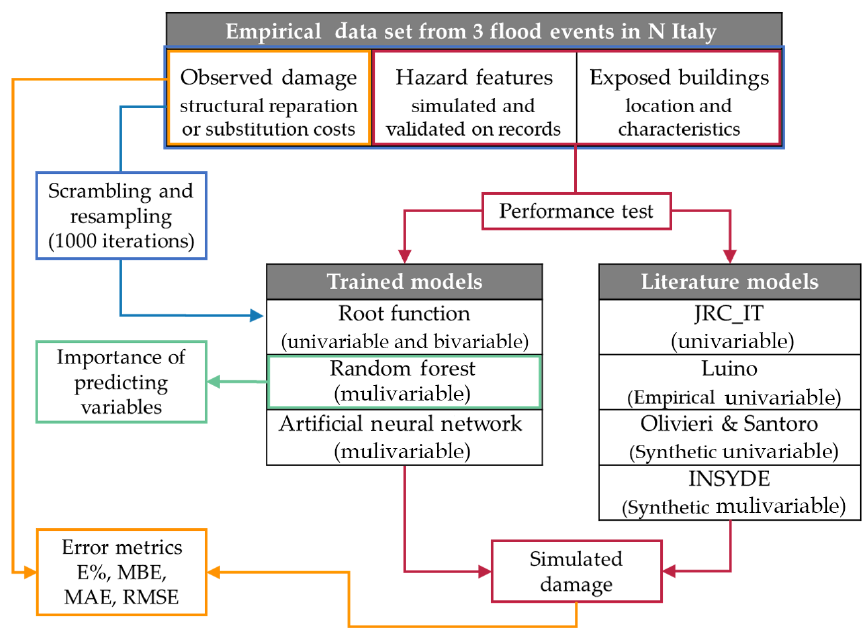
Figure 5. Workflow of the analyses performed in this study.